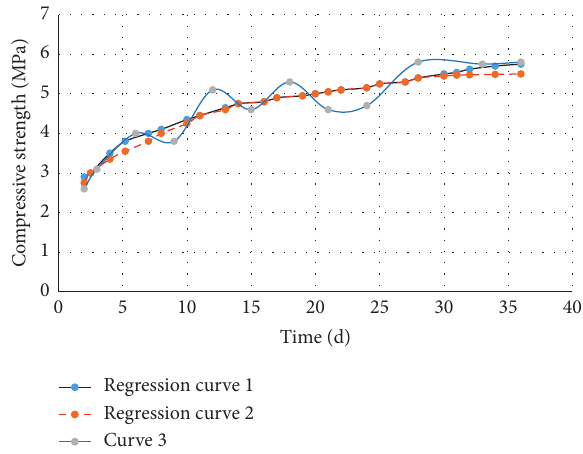
Figure 8: Curves of paste-filling uniaxial compression strength changing with